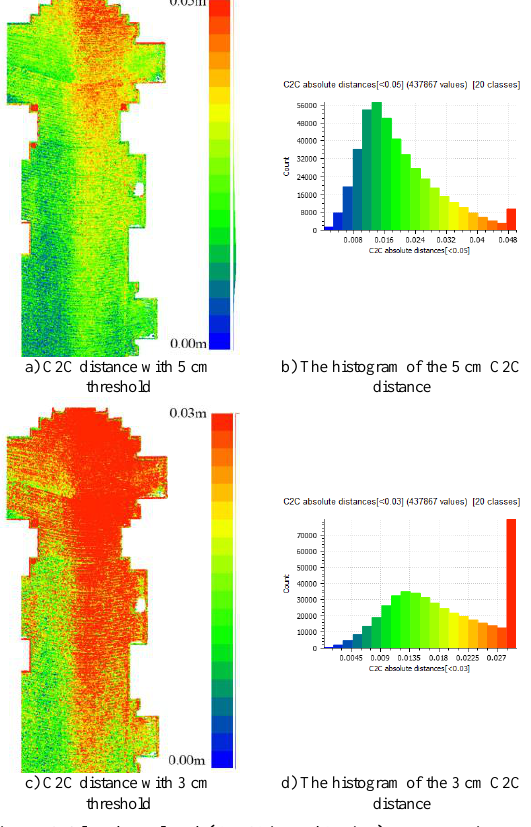
Figure 9 Cloud to cloud (NavVis and Leica) computation top view results in CloudCompare (open